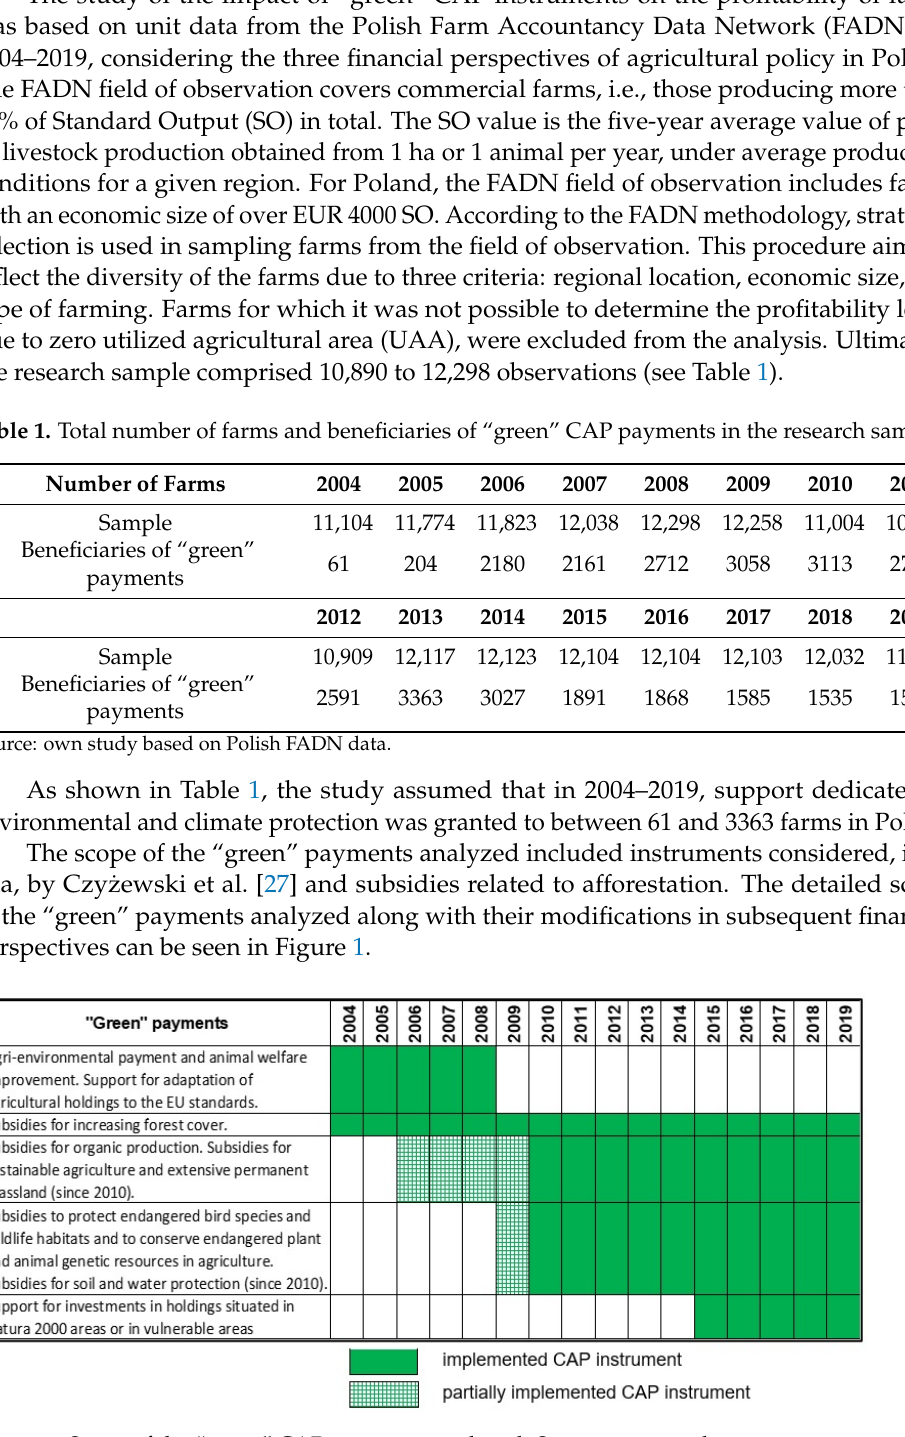
Figure 1. Scope of the “green” CAP payments analyzed. Source: own study.